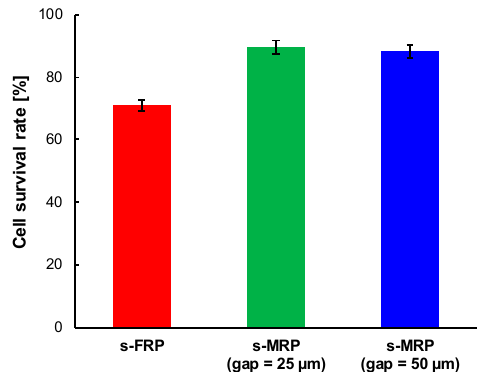
Figure 5. Survival rate of cells which were sent with the s-FRP and two s-MRPs. The survival rates were 71% ± 2% (s-FRP), 90% ± 2% (s-MRP; gap = 25 µ m) and 88% ± 2% (s-MRP; gap = 50 µ